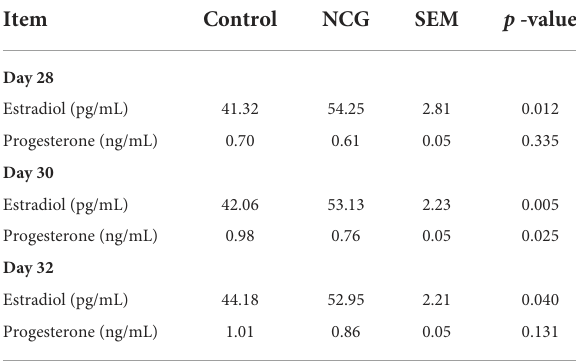
TABLE 1 Levels of serum estradiol and progesterone on days 28, 30, and